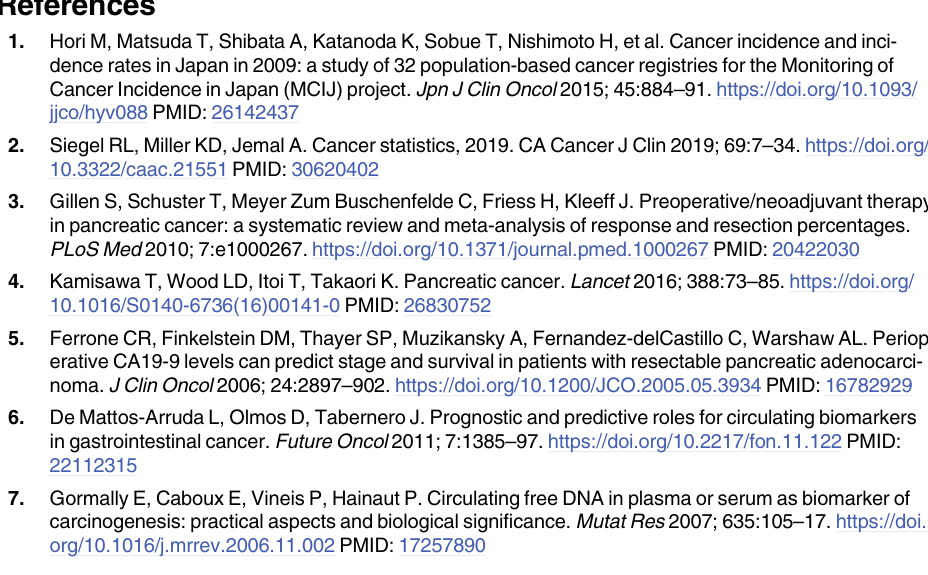
S1 Table. A) Characteristics of patients who underwent surgery. B) Characteristics of patients who did not undergo surgery. S2 Table. Clinical information of patients who underwent surgery. S3 Table. Clinical information of patients who did not undergo